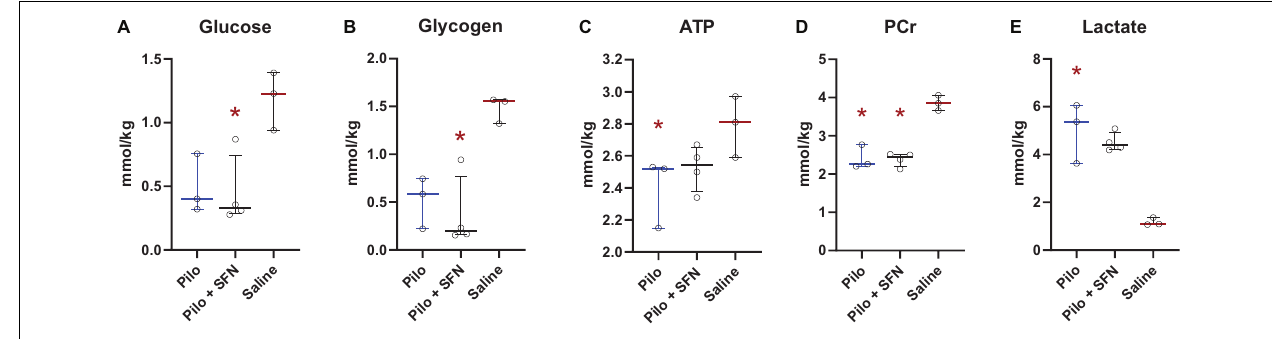
FIGURE 6 | SFN pretreatment does not lead to any significant changes in the brain metabolites, namely Glucose (A) , Glycogen (B) , ATP (C) , PCr (D) and Lactate (E) , determined in Pilo groups when assessed 30 min after the onset of SE. The colour of the significance symbol (*) denotes the group the comparison was made to, and the location of the symbol denotes which was the other group. The Kruskal–Wallis test was followed by post-hoc uncorrected Dunn’s test. All values are reported as median ± interquartile range (* p < 0.05).